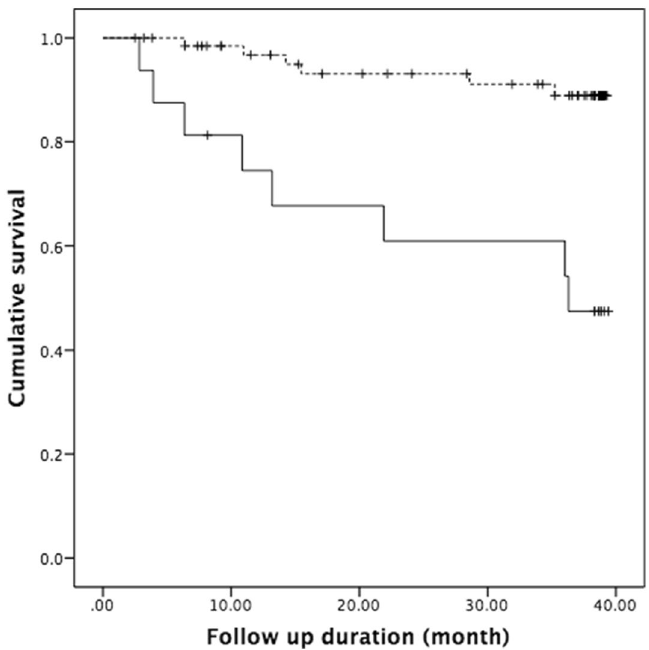
Figure 1. Kaplan–Meier analysis. Patients with small kidney size at the initiation of dialysis (solid line) had lower cumulative survival than patients with enlarged or normal kidney size (dashed line) (log-rank test, chi- squared = 15.614, P <